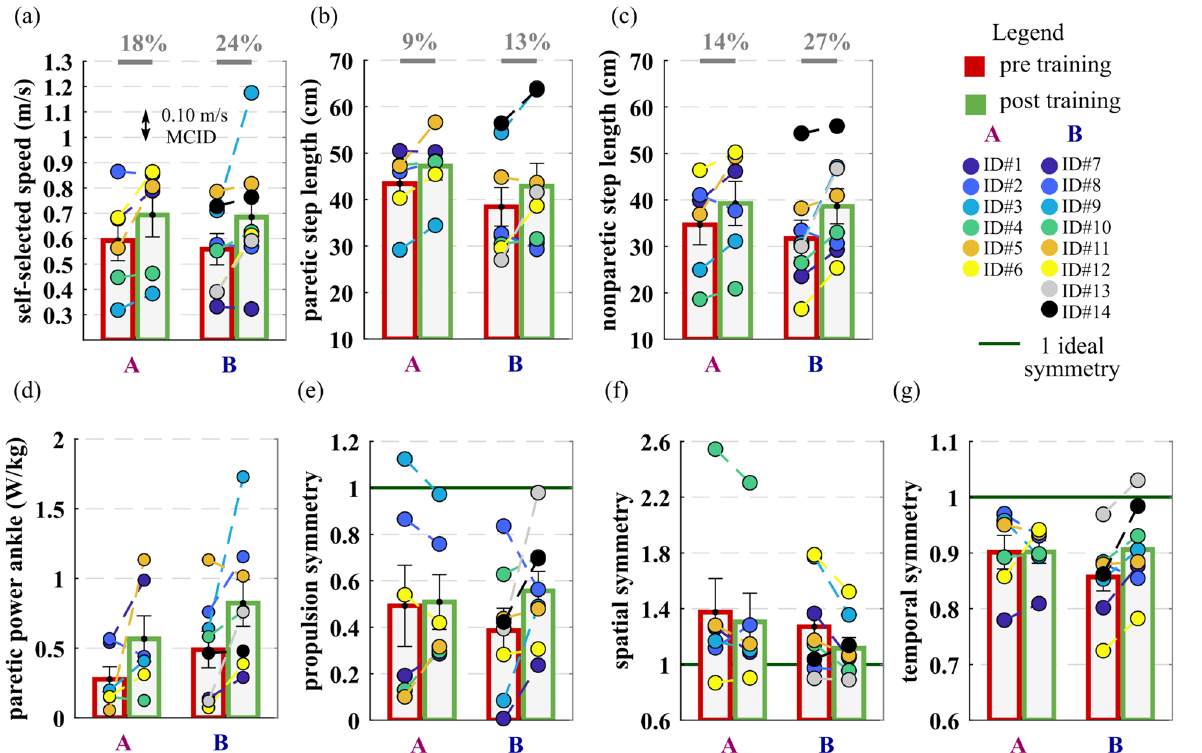
Figure 4. Self-selected speed, spatiotemporal and propulsion parameters pre and post-training. ( a ) Self- selected gait speed (m/s), ( b ) paretic and ( c ) non-paretic step length (cm), ( d ) paretic power ankle (W/kg), ( e ) propulsion symmetry, ( f ) spatial and ( g ) temporal gait symmetry measured during pre (red) and post (green) training gait analysis are shown averaged across group participants (means and standard errors). Circles represent individual study participants. The minimal clinically important difference (MCID) for the speed is depicted in the plot with dashed horizontal After the training, participants significantly increased the steady-state speed during the 6MWT on average by 19 ± 4% (0.13 ± 0.02 m/s, p < 0.001). Both groups A and B increased their steady-state speed, respectively by 0.10 m/s (p = 0.05) and 0.16 m/s (p = 0.008), from pre-training NoAPO (0.74 ± 0.29 m/s group A, 0.75 ± 0.25 m/s group B) to post-training NoAPO (0.84 ± 0.29 m/s group A, 0.90 ± 0.27 m/s group B). When walking with the APO, participants increased their steady-state speed on average by 15 ± 5% (0.09 ± 0.04 m/s, p = 0.03) comparing the 6MWT APO at the end of the training (0.83 ± 0.25 m/s group A, 0.84 ± 0.30 m/s group B) with the pre-training 6MWT NoAPO [Fig. 3b]. The self-assessment of the task intensity measured using the Borg Scale did not change significantly from pre- to post-training for both groups. Borg scale scores, heart rate and walked distance of all 6MWTs performed are reported in supplementary materials (Supplementary Fig. 2, Supplementary Table III). Secondary outcomes. Self-selected gait speed. GA data showed a significant increase in the self-selected walking speed of 21 ± 6% (0.12 ± 0.04 m/s, p = 0.007) after 2-day of training [Fig. 4a]. In particular, the self-se- lected walking speed increased on average by 18 ± 6% in group A and by 24 ± 10% in group B, from pre-training (0.59 ± 0.08 m/s group A, 0.56 ± 0.06 m/s group B), to post-training (0.69 ± 0.09 m/s group A, 0.68 ± 0.09 m/s for group B). On average, both groups showed a clinically meaningful change (≥ 0.10 m/s MCID 65 ) in the comfort- able walking speed, respectively by 0.10 m/s for group A and 0.13 m/s for group B. Gait symmetry. On average, study participants significantly improved the spatial symmetry by 0.11 ± 0.04 (p = 0.03), when comparing pre-training (1.32 ± 0.12) and post-training (1.20 ± 0.08). The spatial gait symmetry improved respectively by 0.08 ± 0.06 for group A and by 0.14 ± 0.06 for group B [Fig. 4f]. This improvement in the spatial symmetry resulted from a significant increase in step length on both the paretic and non-paretic limbs, by 11 ± 4% (4 ± 1 cm, p = 0.01) and by 21 ± 6% (6 ± 2 cm, p = 0.003) respectively [Fig. 4b,c]. The temporal symmetry significantly improved in group B by 0.04 ± 0.02 (p = 0.03), when comparing pre- training (0.86 ± 0.03) and post-training (0.91 ± 0.03) GAs, while in group A, on average, it did not change (0.00 ± 0.02), [Fig. 4g].